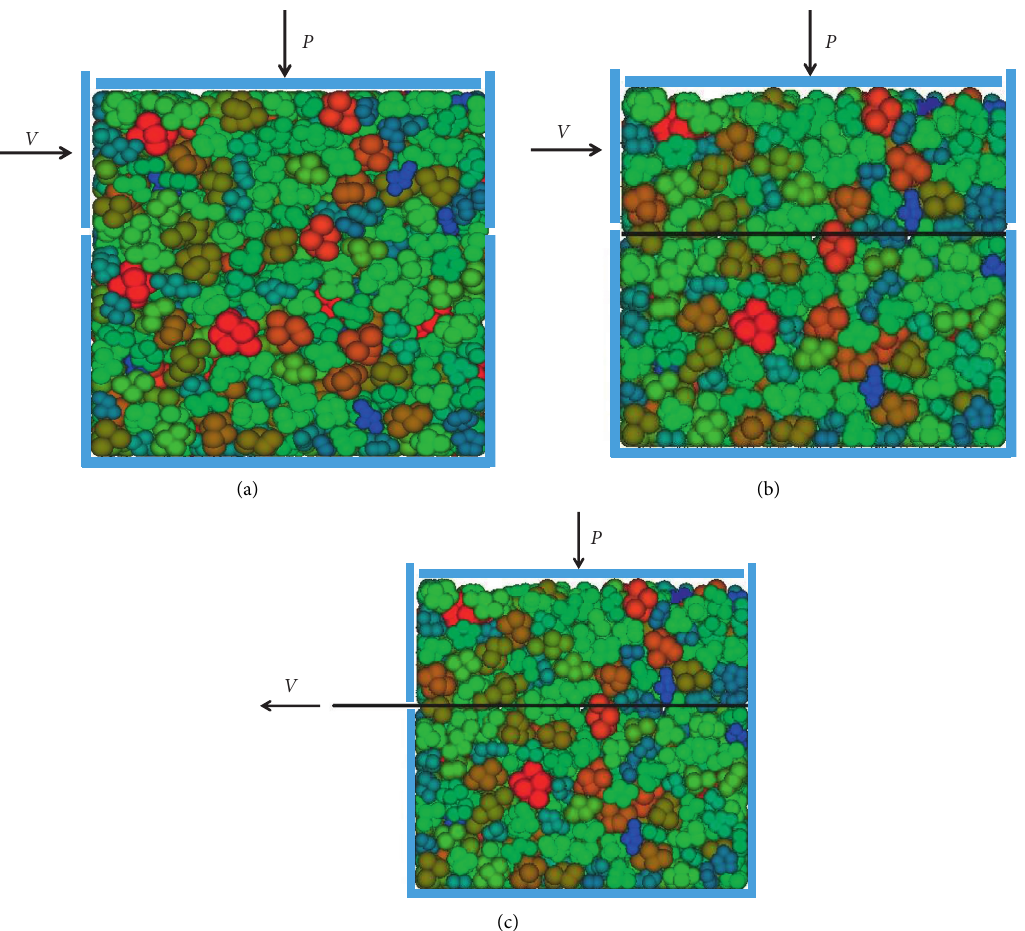
Figure 5: Numerical models of direct shear test without and with geogrid and pull-out test. (a) DEM model of direct shear test of